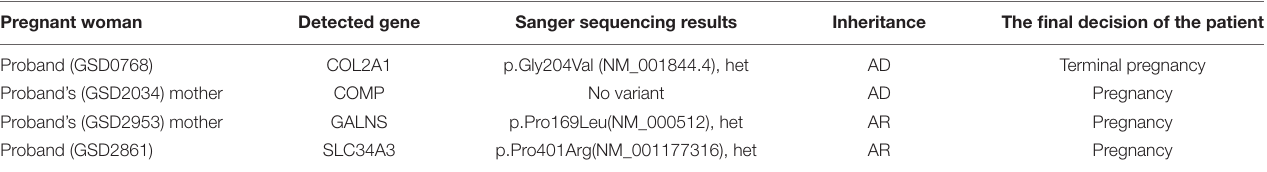
TABLE 4 | Prenatal genetic diagnosis in four families with molecular diagnoses. Pregnant